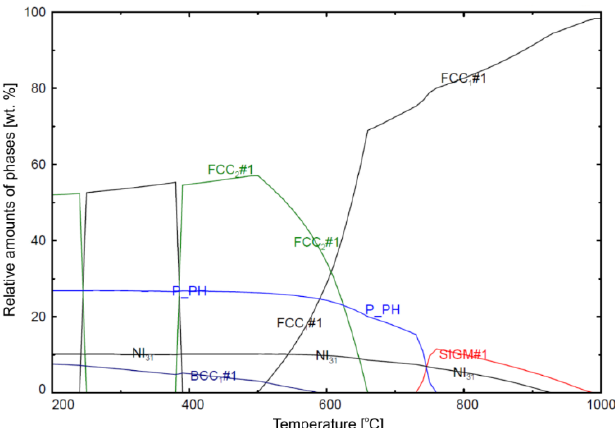
Figure 3. Calculated relative amounts of equilibrium phases in Inconel 625 alloy as a function of temperature.